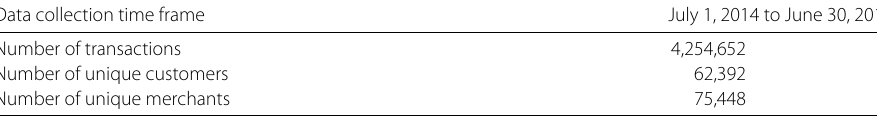
Table 1 Credit card dataset